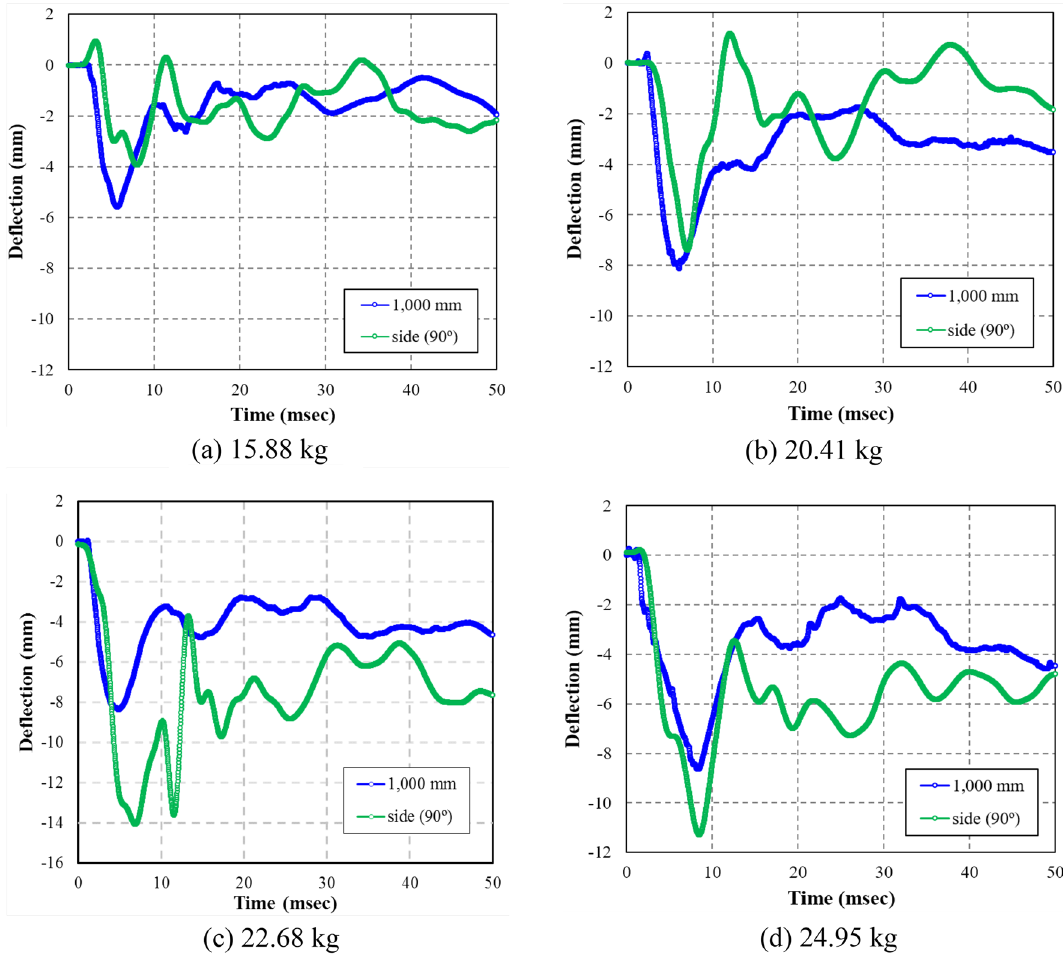
Figure 10. Time-deflection curves of LVDT 2 (1000 mm) and LVDT 3 (side 90°). ( a ) 15.88 kg. ( b ) 20.41 kg. ( c ) 22.68 kg. ( d ) 24.95 kg.